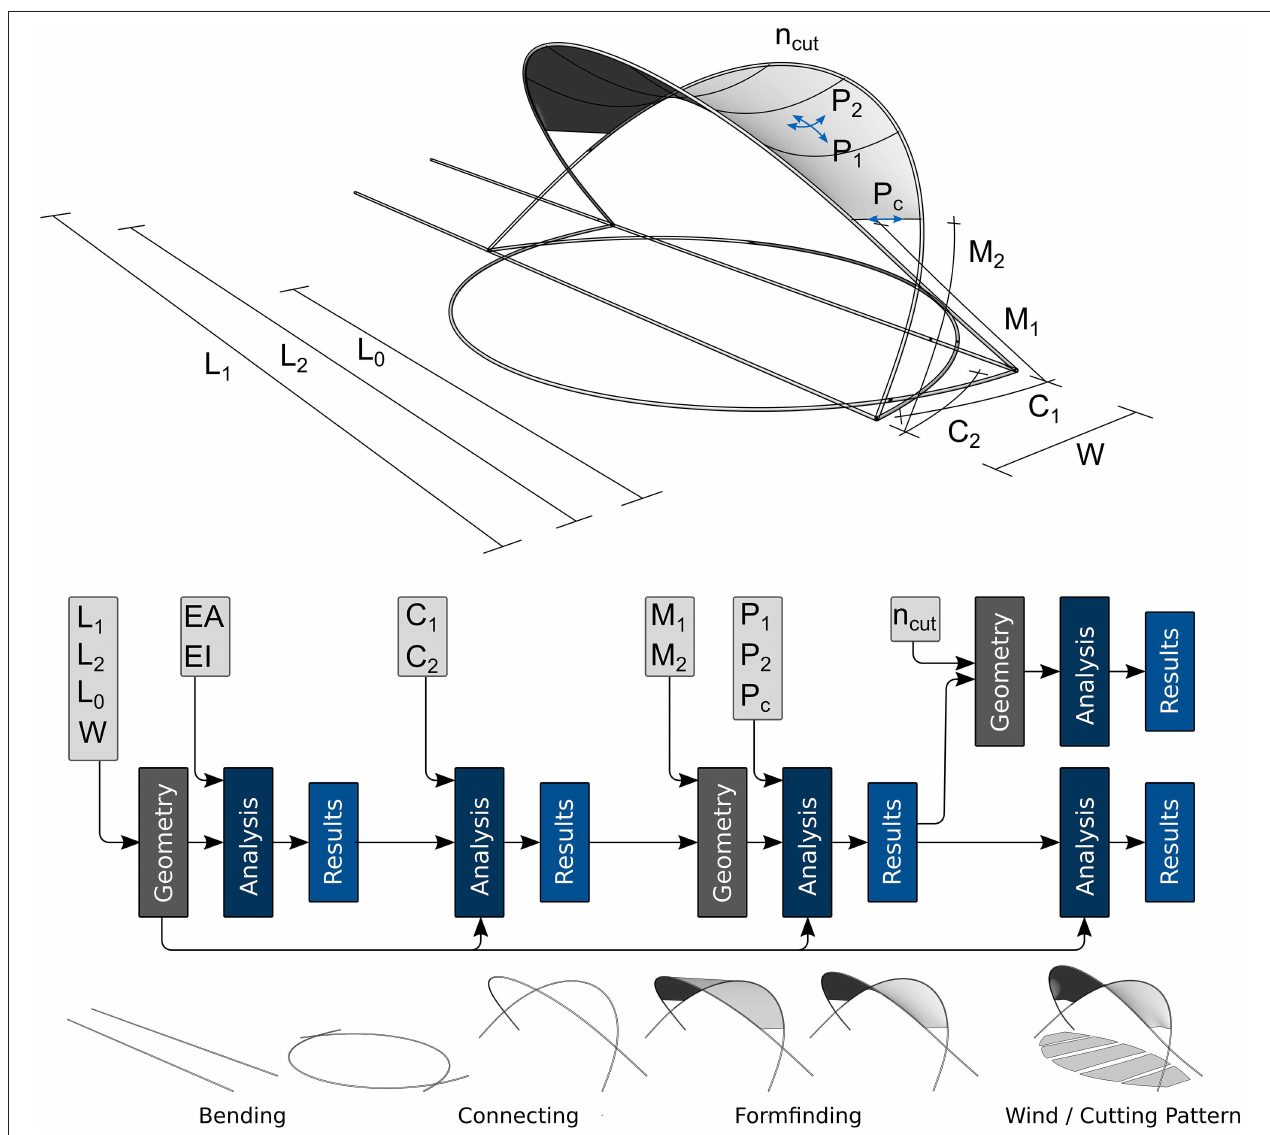
FIGURE 10 | Parametric formfinding process of the beach bar with linked consecutive analyses: initially straight rods, actively bent rods, upright rods with joined connection points, added membrane elements, formfound hybrid structure, final beach bar model subjected to wind uplift and cutting pattern generation.